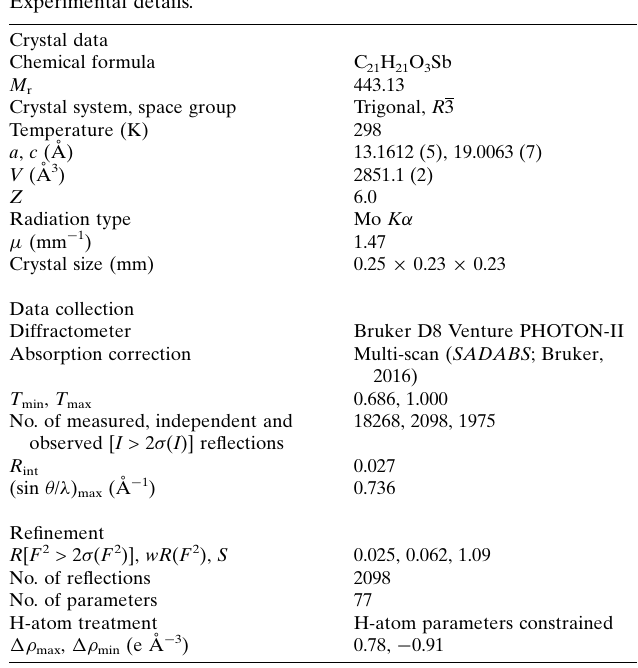
Table 2 Experimental